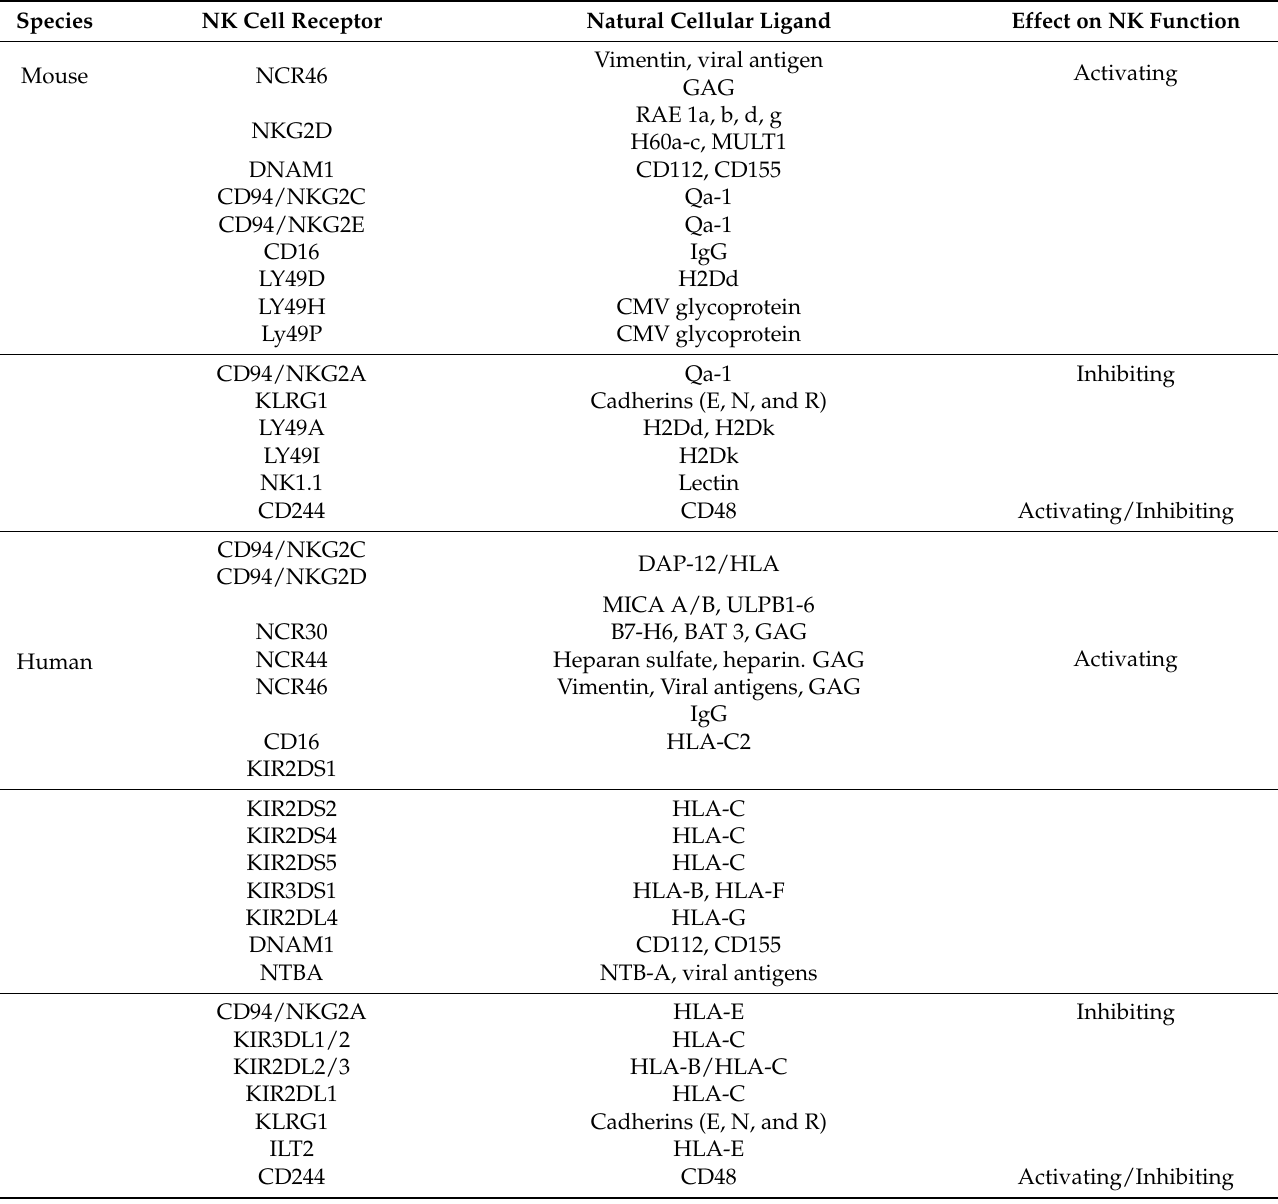
Table 1. NK receptors are involved in NK function and pathogen